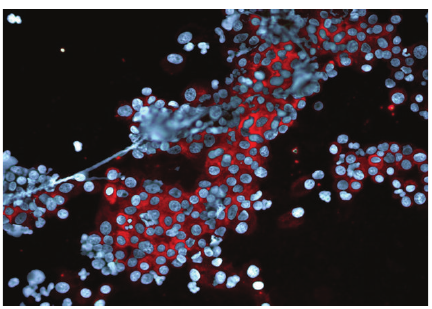
Figure 3: CD117 immunocytofluorescence has confirmed MCT subpopulation in the aspirate. The nuclei were stained blue by DAPI. Notably, some cells were non-MCT cells because of lack of CD117 immunopositivity in their cytoplasm and on plasma membranes.